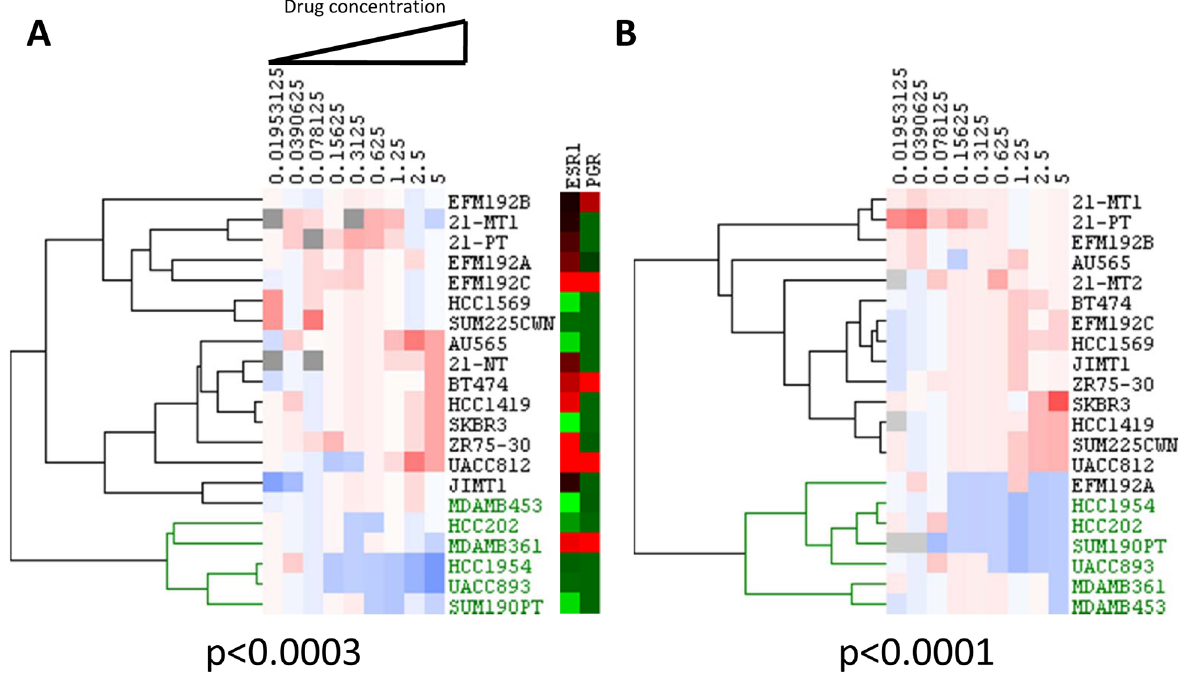
Fig 2. Combination index (CI) values were calculated for each of the nine dose combinations tested for each cell line and then clustered to generate synergy heatmaps for HER2 positive breast cancer cell lines treated with AKT inhibitors: A. GSK690693; B. GSK2141795. Blue indicates a significant synergistic CI value (CI < 0.8, upper 95% confidence interval is less than 1), white indicates additivity, and red indicates significant antagonism (CI > 1.2, lower 95% confidence interval is greater than 1). Gray represents instances where no CI could be calculated. A significant association between synergy and PI3K pathway mutation status was indicated by clustering, which was confirmed by Fisher ’ s exact test for A and B . Cell lines in green harbor hotspot PIK3CA mutations.